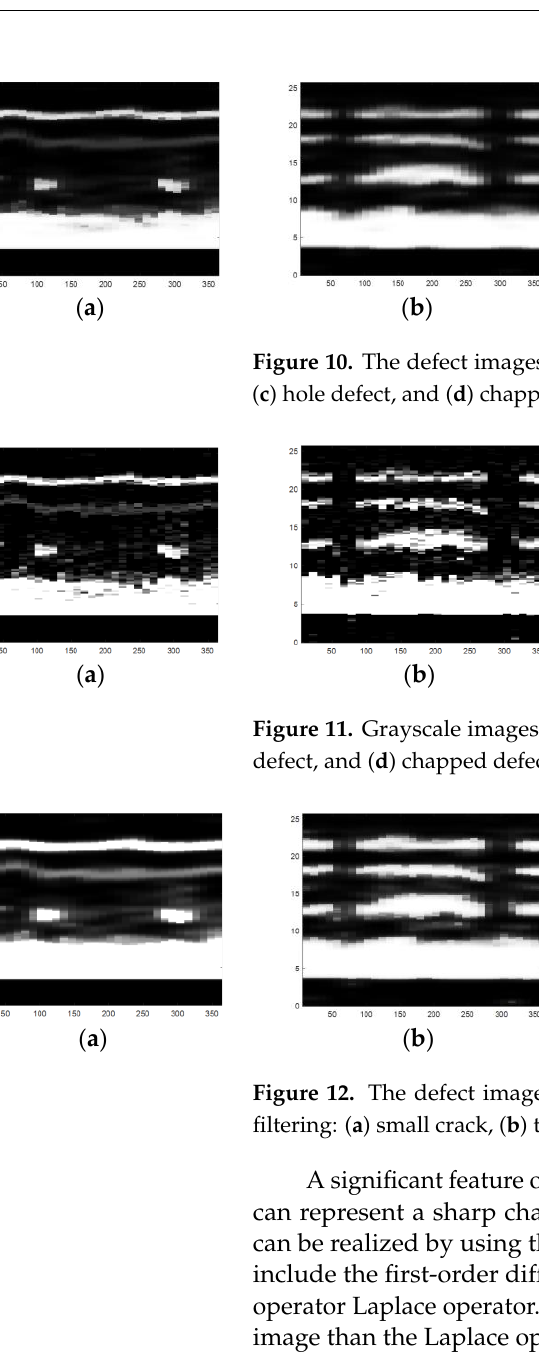
Figure 13. The defect images processed by the Laplacian operator: ( a ) small crack, ( b ) transverse crack, ( c ) hole defect, and ( d ) chapped defect.